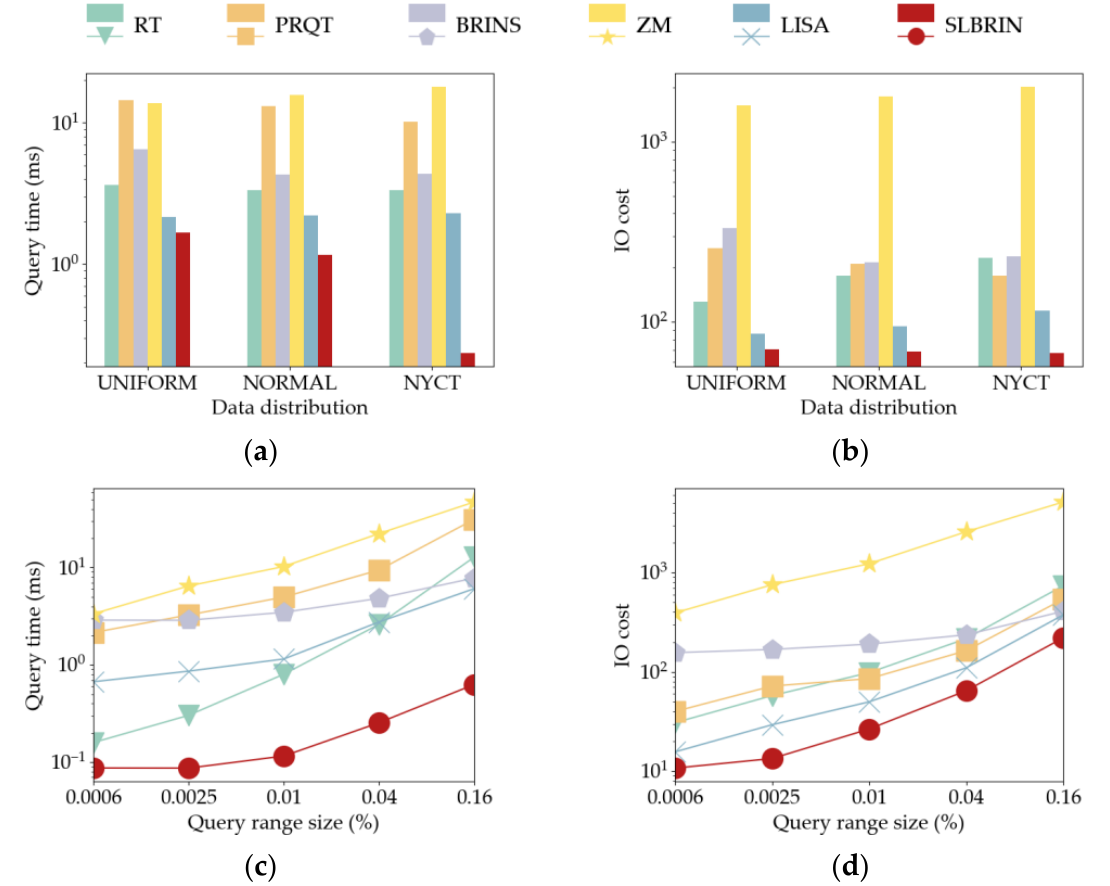
Figure 7. Range query performance. ( a , b ) Vs. data distribution. ( c , d ) Vs. query range size on NYCT.